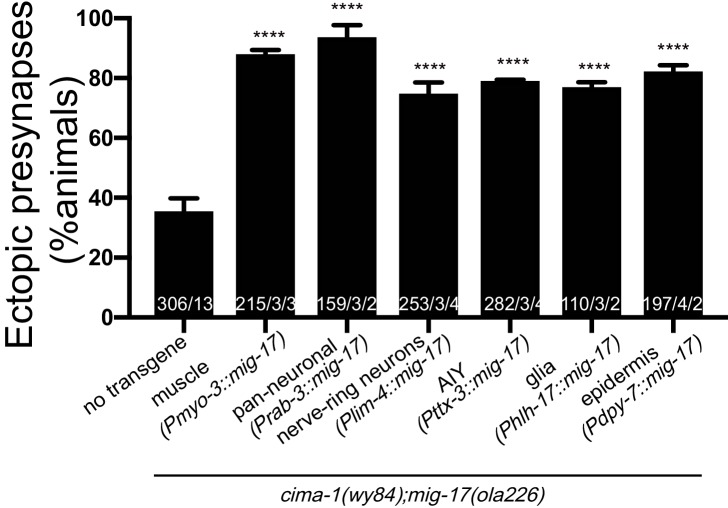
Cell-specific expression of mig-17 in multiple tissues rescues the mig-17 suppression in mig-17(ola226);cima-1(wy84) mutants.Quantification of the percentage of adult animals with ectopic synapses in the AIY Zone 1 region in the indicated genotypes. The body wall muscle rescue and the pan-neuronal rescue are the same as in Figure 5E. In the graph, the total number of animals (N) and the number of times scored (n1) are indicated in each bar for each genotype, as are, for the transgenic lines created, the number of transgenic lines (n2) examined (all using the convention N/n1/n2). Statistical analyses are based on one-way ANOVA by Tukey’s multiple comparison test. Error bars represent SEM. ****p<0.0001 as compared to the no-transgene control.